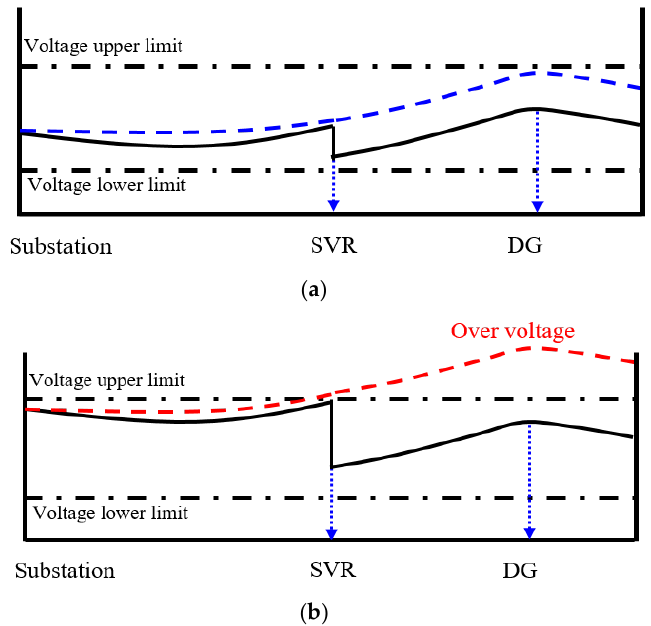
Figure 4. Voltage Profiles under Neutral Mode.